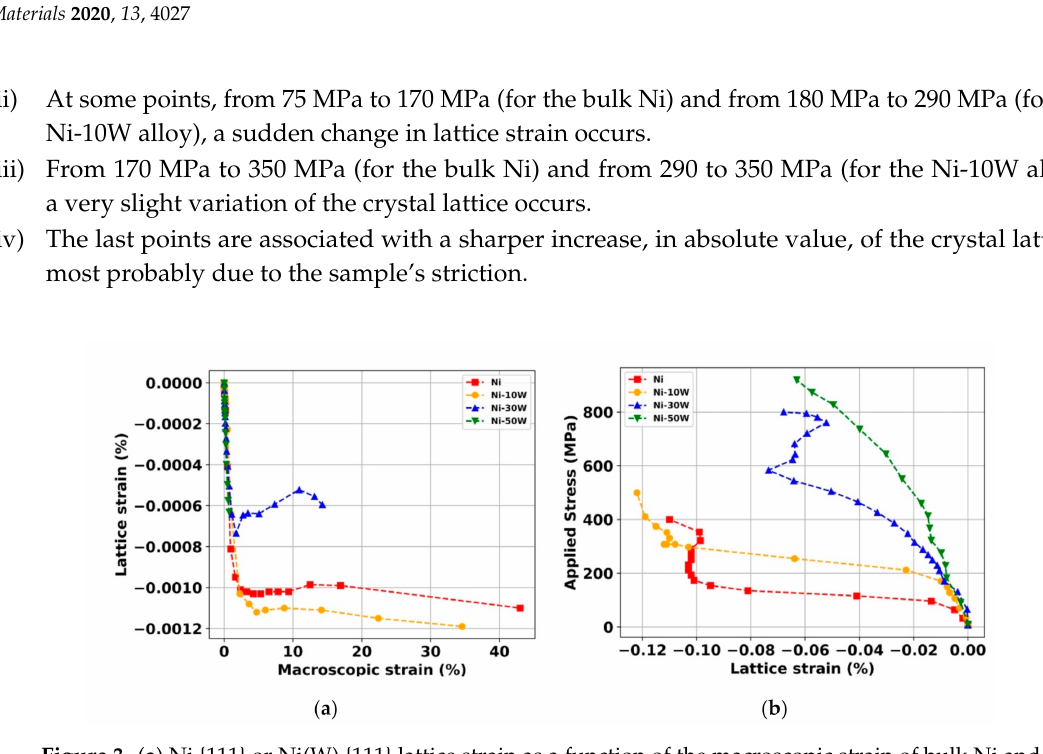
Figure 3. ( a ) Ni {111} or Ni(W) {111} lattice strain as a function of the macroscopic strain of bulk Ni and Ni-W alloys. ( b ) Applied stress as a function of the Ni {111} or Ni(W) {111} lattice strain of the bulk Ni and Ni-W